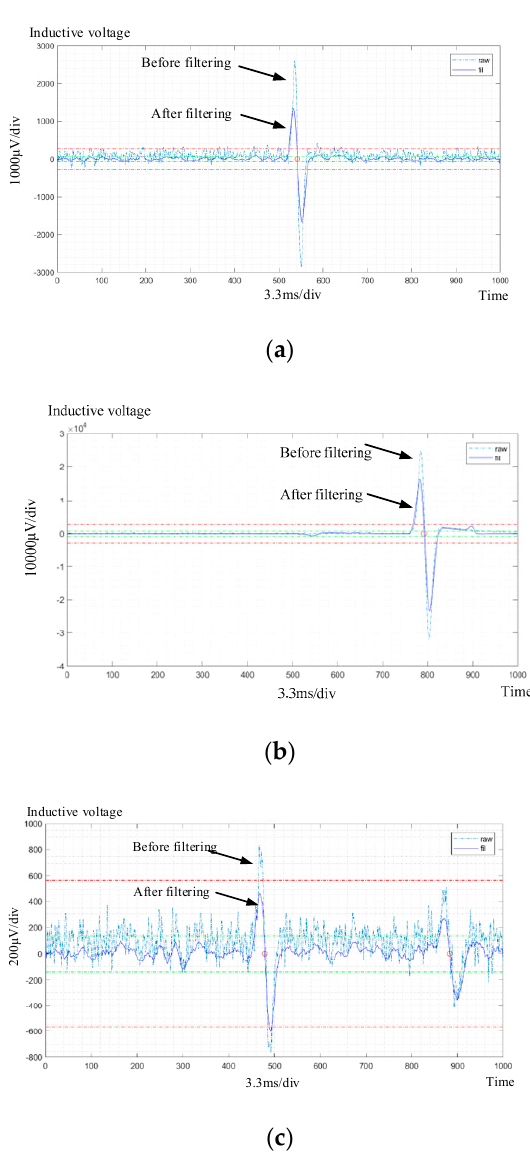
Figure 13. Abrasive particle waveforms in the early warning. ( a ) The waveform of 280 μ m diameter abrasive. ( b ) The waveform of 1 mm diameter abrasive. ( c ) The waveform of two abrasive pass through the sensor successively.